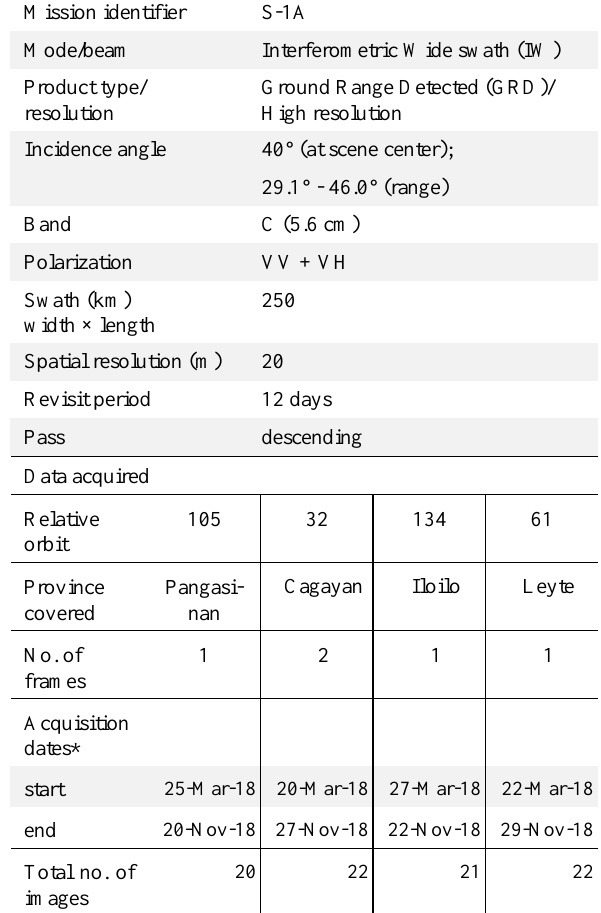
Table 1. Sentinel-1A sensor specifications and data